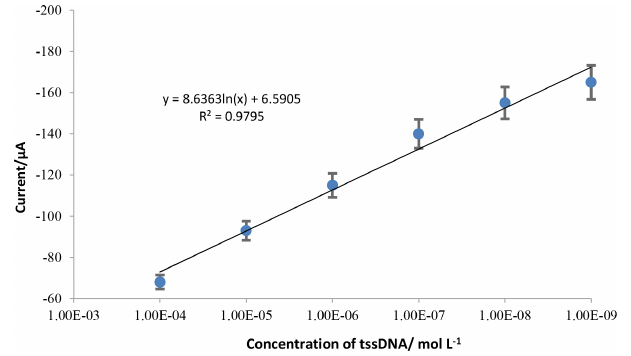
Figure 4. EIS; (a) electrode with tssDNA; (b) electrode with ZnS nanospheres and tssDNA; (c) electrode with pssDNA and tssDNA; (d) electrode with ZnS nanospheres, pssDNA, and tssDNA; elec- trolyte binding buffer (50mM Tris-HCl, 100mM NaCl, 15mM KCl, 10mM MgCl 2 , and 5% ethanol; pH7.4); the frequency for EIS was 0.05–100kHz.